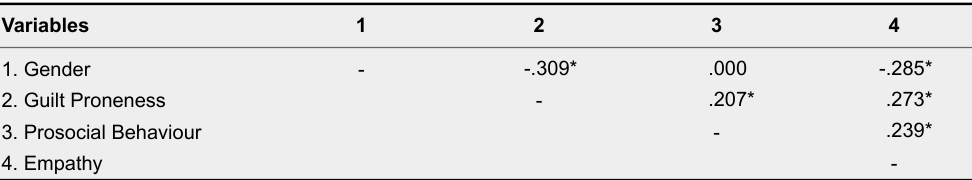
Correlation Between Variables 4321Variables -1.